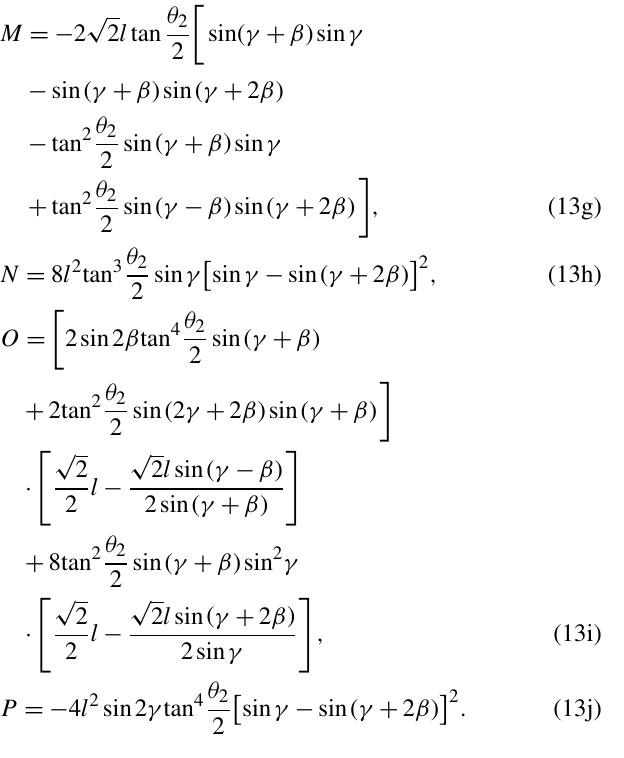
Substituting Eqs. (18)–(20) into Eqs. (15) and (16),